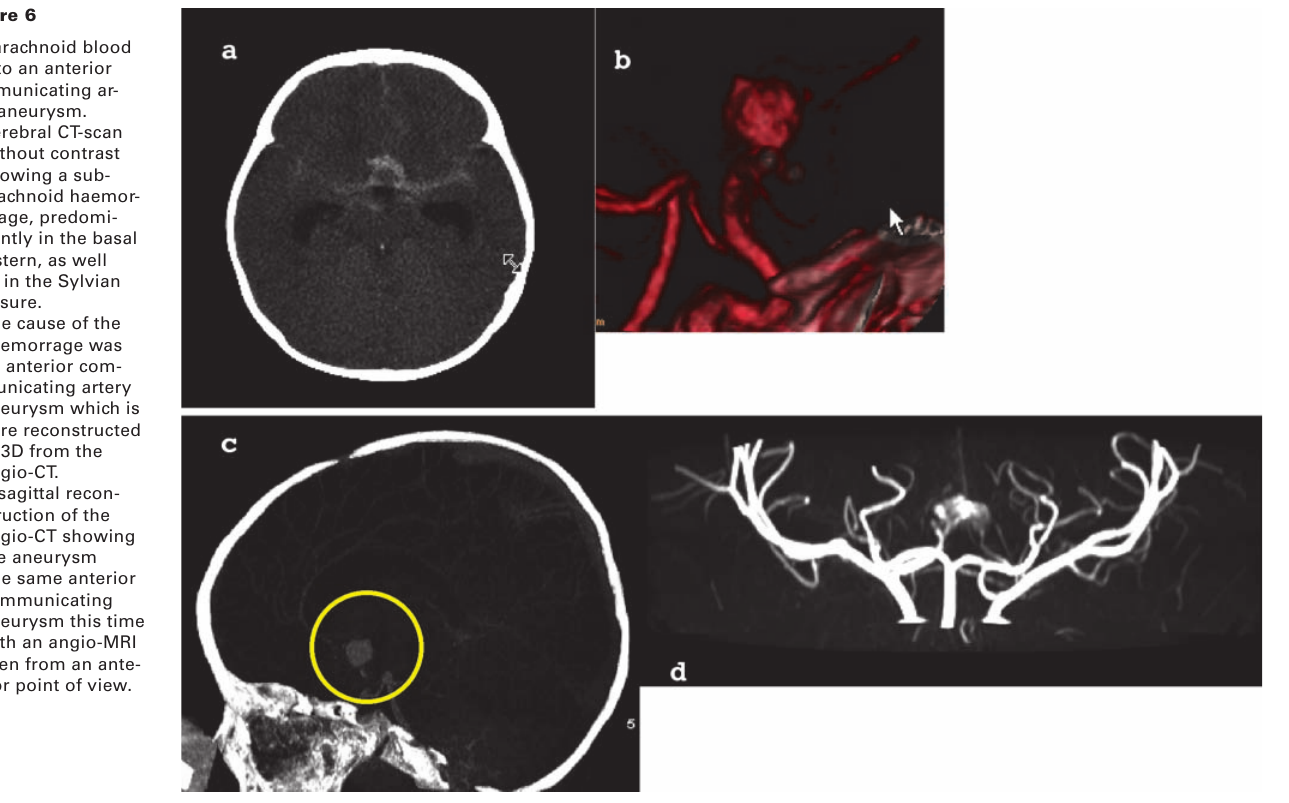
Subarachnoid blood due to an anterior communicating ar- tery